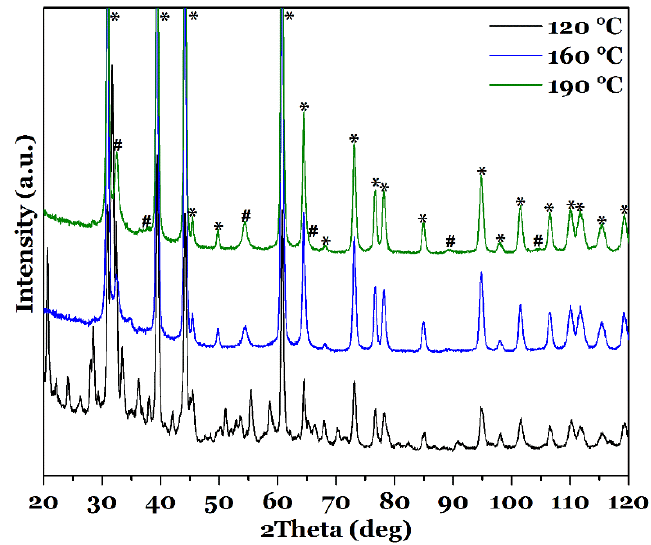
Figure 6. XRD pattern of CuInS 2 films synthesized with L -cysteine at different reaction temperatures, 120, 160 and 190 °C, for 18 h. Signals stemming from FTO are marked with *, the ones originating from CuInS 2 with #.